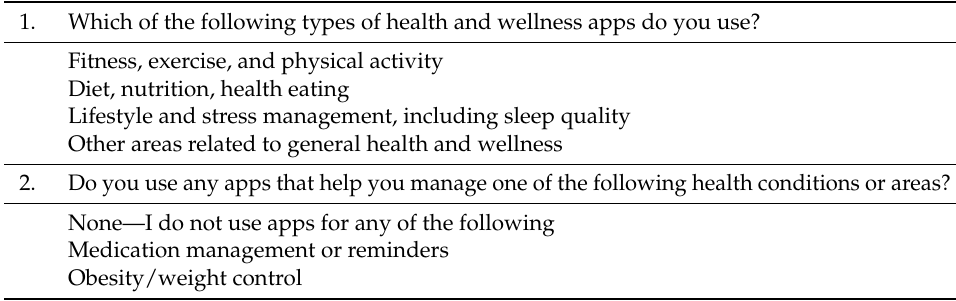
Table 1. mHealth Survey